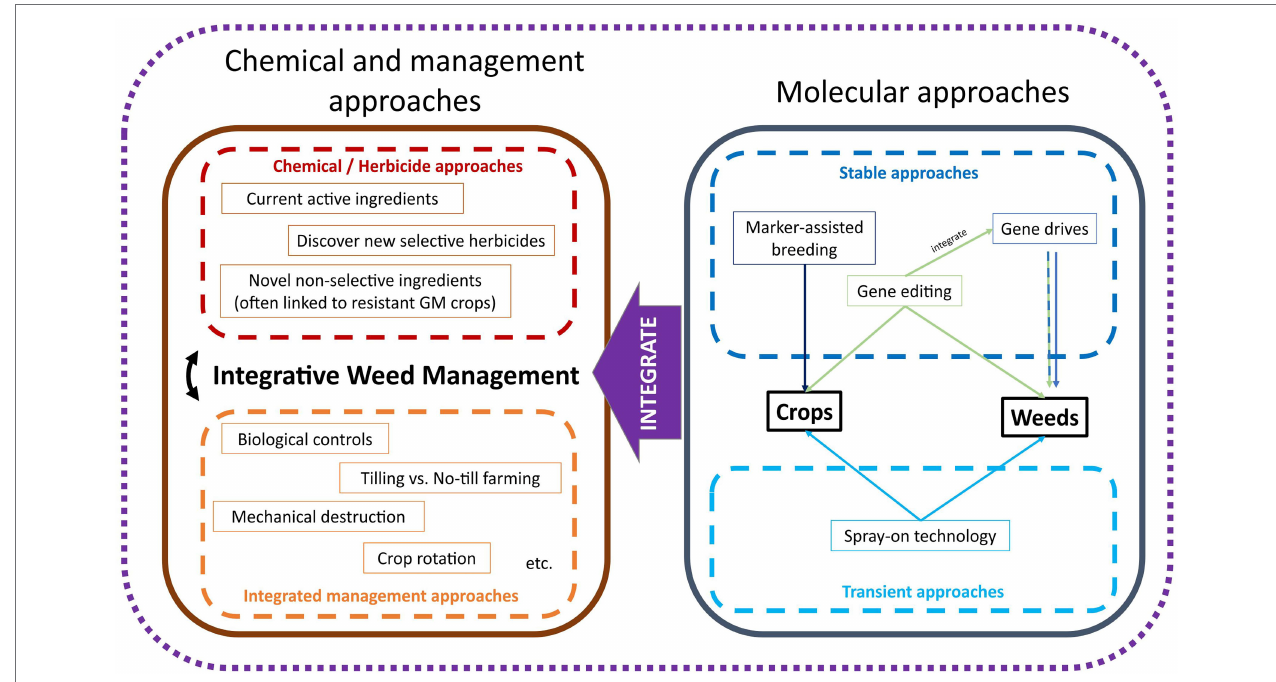
FIGURE 1 | A conceptual framework for innovative weed management. Conventional approaches using chemicals and farm management are often applied together and can be improved or integrated with biotechnological approaches for future weed management. Biotechnological weed management can be applied to crops or weeds via stable and transient